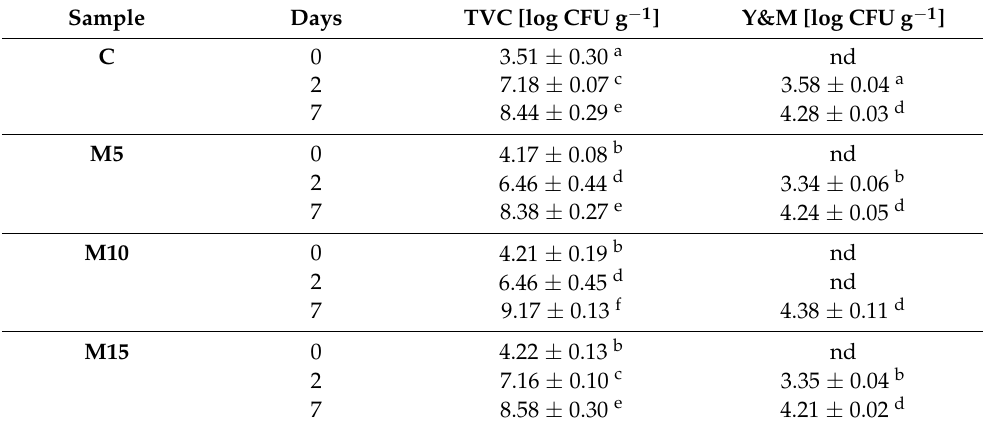
Table 5. Microbiological analysis of the tested breads after production and after 2 and 7 days of